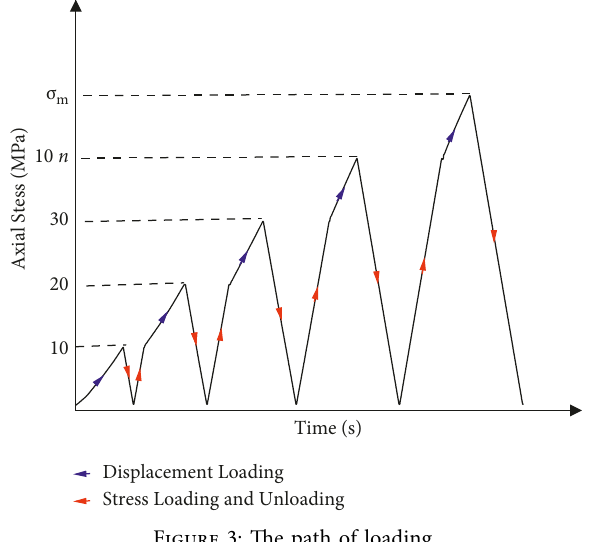
Figure 3: The path of loading.